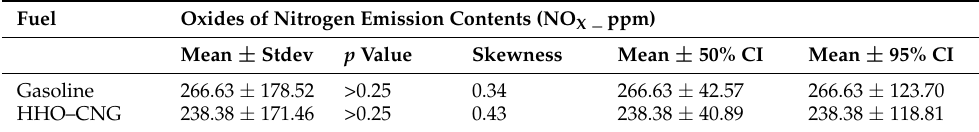
Table 8. Average NOx emission contents for 50 and 95% confidence